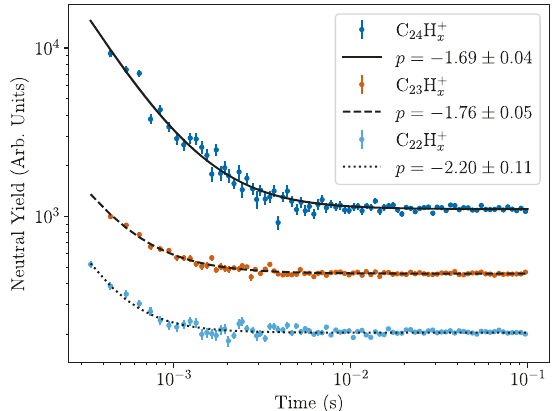
Fig. 4 Neutral yields from the spontaneous decay of C 24 H þ x , C 23 H þ x , and C 22 H þ x ions as a function of the storage time in DESIREE. The curves show fi ts Eq. (1) and the respective exponents are given in the legend. The different data sets have been offset vertically to improve legibility. The constant levels reached after 10 ms are dominated by the detector background and are the same for all three measurements before they are shifted. Note the log-log scale. The error bars represent the 1 σ statistical uncertainties of each data point. Source data are provided as a Source Data fi le.